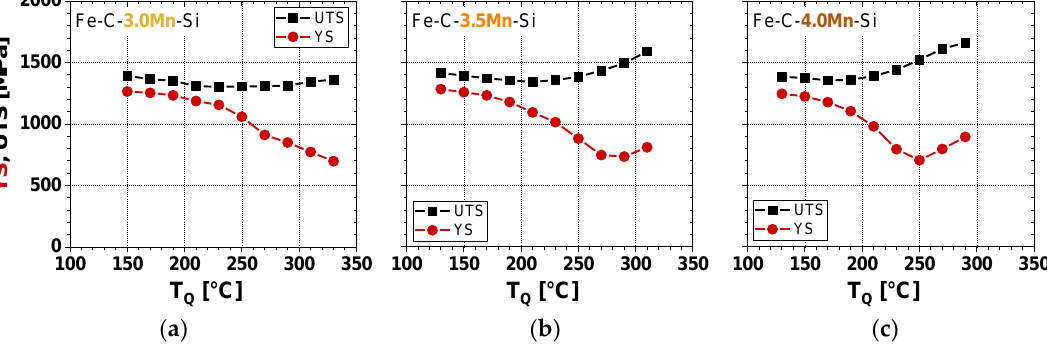
Figure 7. YS and UTS as a function of T Q for the ( a ) Fe-C-3.0Mn-Si, ( b ) Fe-C-3.5Mn-Si and ( c ) Fe-C-4.0Mn-Si steels.